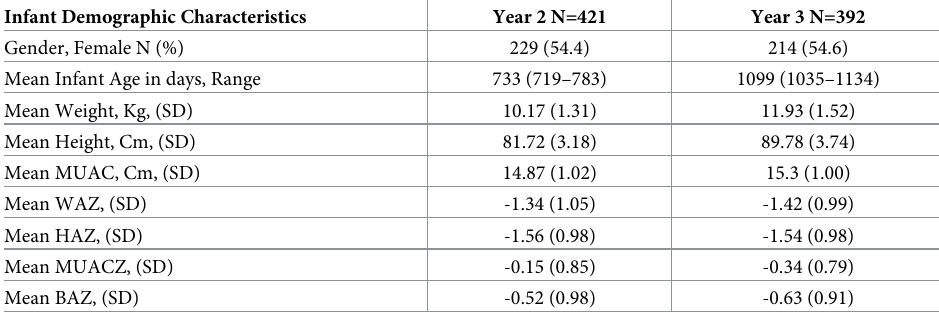
Table 5. Infant demographic